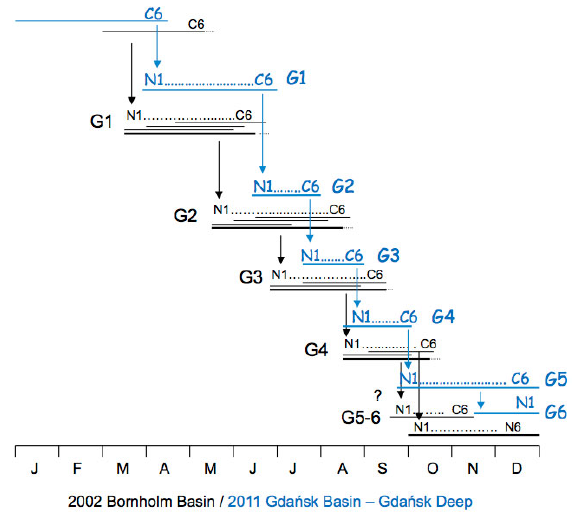
Fig. 8. Scheme of Temora longicornis life cycles for the Gda ń sk Basin – Gda ń sk Deep (this study – blue colour) and the Bornholm Basin (black colour). G1–G6,